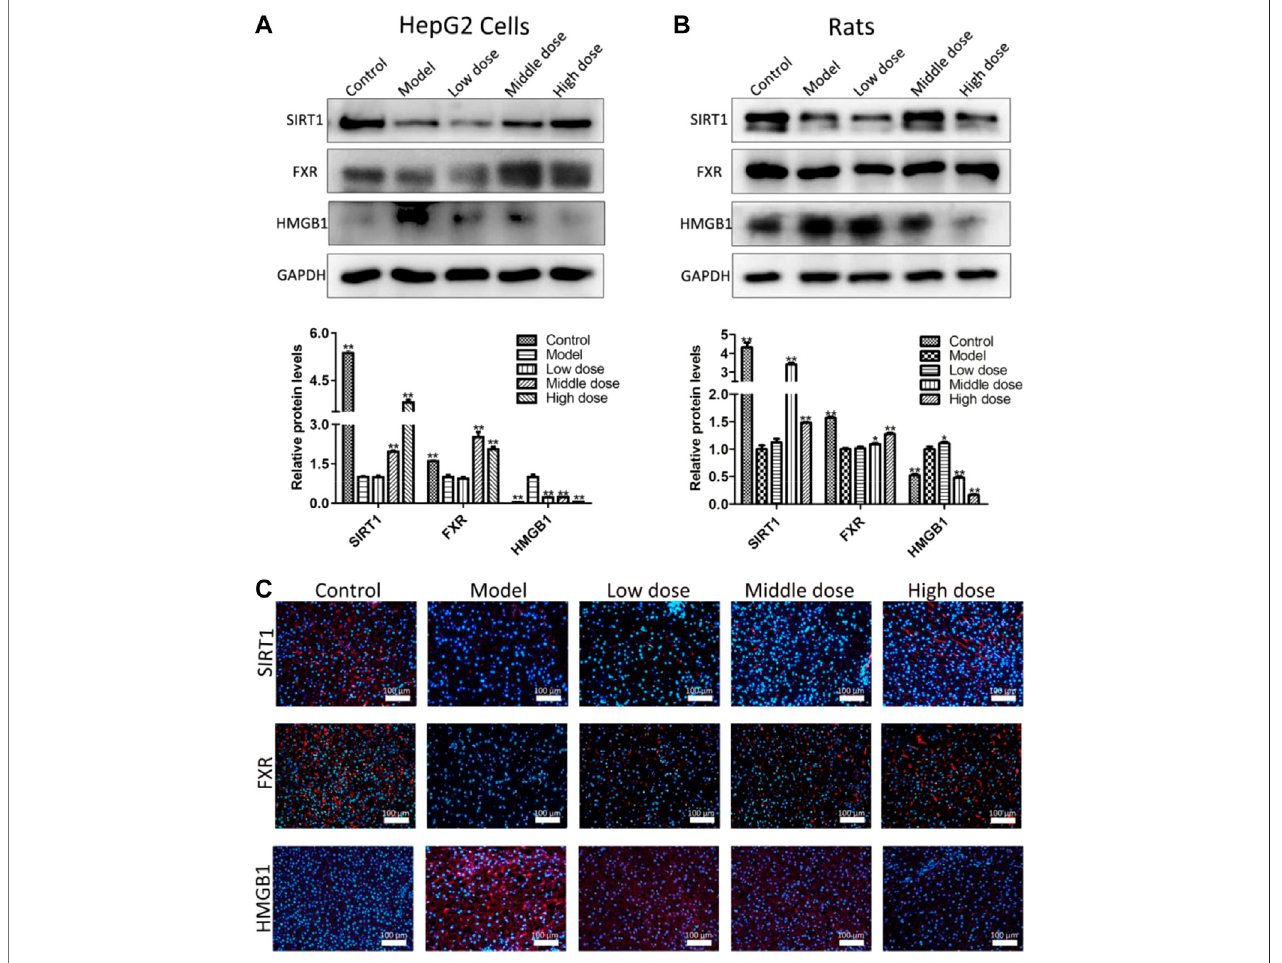
FIGURE 4 | Aromatic vinegar activates the silent information regulator of transcription 1 pathway in vitro and in vivo . (A) Effects of aromatic vinegar on the expression levels of SIRT1, farnesoid X receptor (FXR) and high mobility group box 1 (HMGB1) in vitro ; (B) Effects of aromatic vinegar on the expression levels of SIRT1, FXR and HMGB1 in vivo ; (C) Effects of aromatic vinegar on SIRT1, FXR and HMGB1 levels based on immuno fl uorescence staining in vivo ( × 200 magni fi cation). Scale bar (cid:2) 100 µm. Values are expressed as the mean ± SD (n (cid:2) 3). * p < 0.05, ** p < 0.01 compared with model groups.